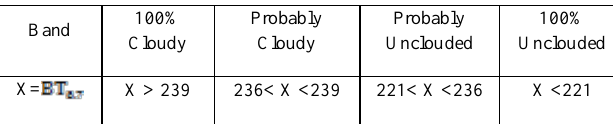
Table 2: The calculated threshold for ( (April 20th)